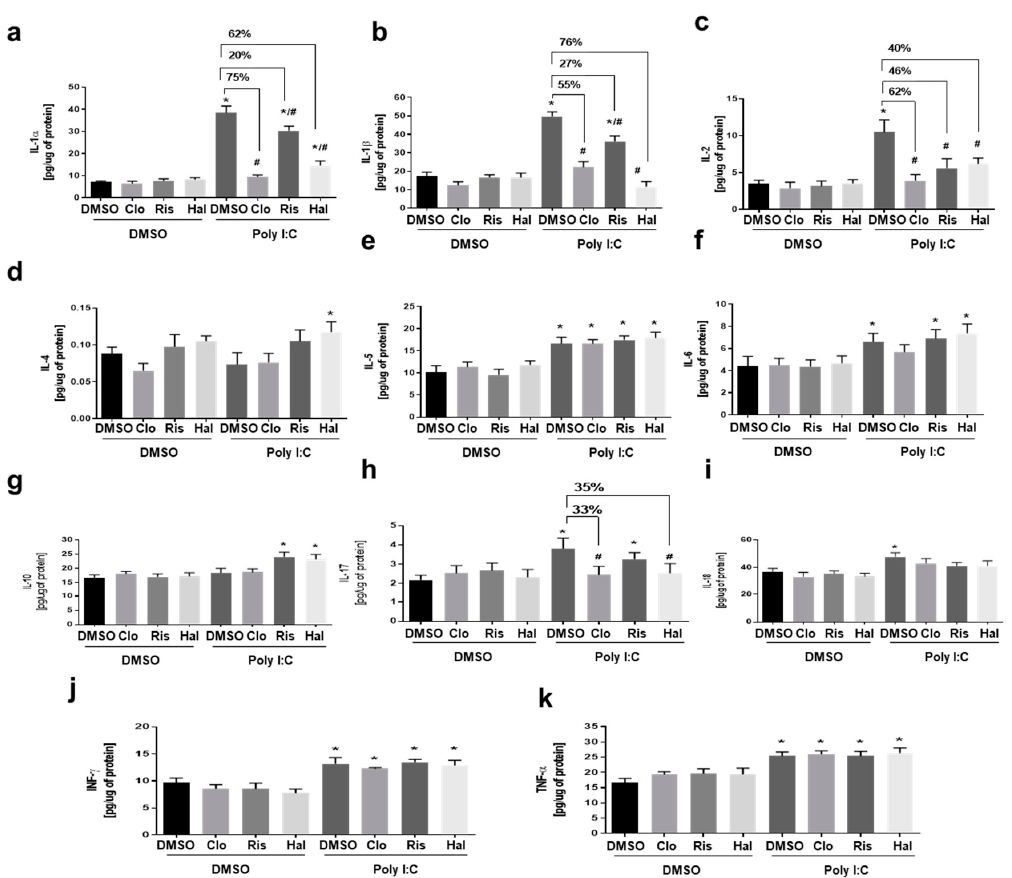
Figure 2. The effect of antipsychotics on poly (I:C)-induced cytokine levels: The effect of antipsychotics on ( a ) IL-1 α , ( b ) IL-1 β , ( c ) IL-2, ( d ). IL-4, ( e ). IL-5, f. IL-6, ( g ) IL-10, ( h ) IL-17, ( i ) IL-18, ( j ) INF- γ , and ( k ). TNF- α cytokines in poly (I:C)-stimulated microglia. Microglia were exposed to poly (I:C) (10 μ g/mL) to simulate viral stimulation and then immediately treated with antipsychotics for 24 h. The experiments were performed with each sample in triplicate. clozapine (CLO), risperidone (RIS), haloperidol (HAL). The data are expressed as the mean ± SD of three independent experiments. * p < 0.05 vs. control samples. # p < 0.05 vs. poly (I:C)-treated samples.